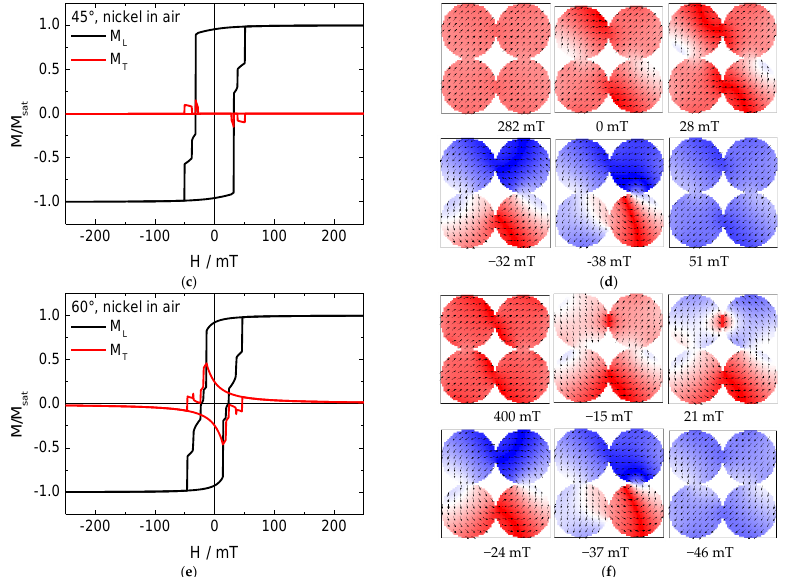
Figure 3. ( a , c , e ) Hysteresis loop and ( b , d , f ) snapshots of the magnetization reversal from positive to negative saturation for a pure nickel nanodot array in air, simulated for the angles depicted in the graphs. This already shows that combining materials with relatively weak and significantly stronger anisotropies may lead to new, sometimes unexpected, magnetization reversal processes that can be used for new applications. It should be mentioned that no sign of coherent magnetization reversal is visible in the transverse magnetization loops. Slight differences between the hysteresis loops simulated at 30° and 60° can be at- tributed to the random crystallographic orientations, chosen arbitrarily at the beginning of each simulation, as mentioned in Section 2.